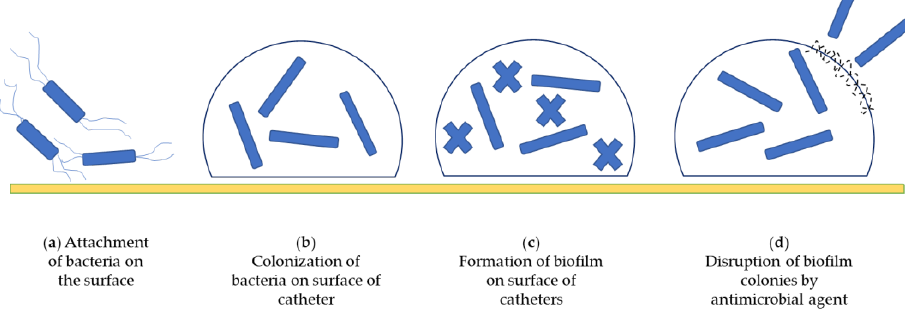
Figure 6. Disruption of biofilm colonization on surface of urinary catheter by antimicrobial action.